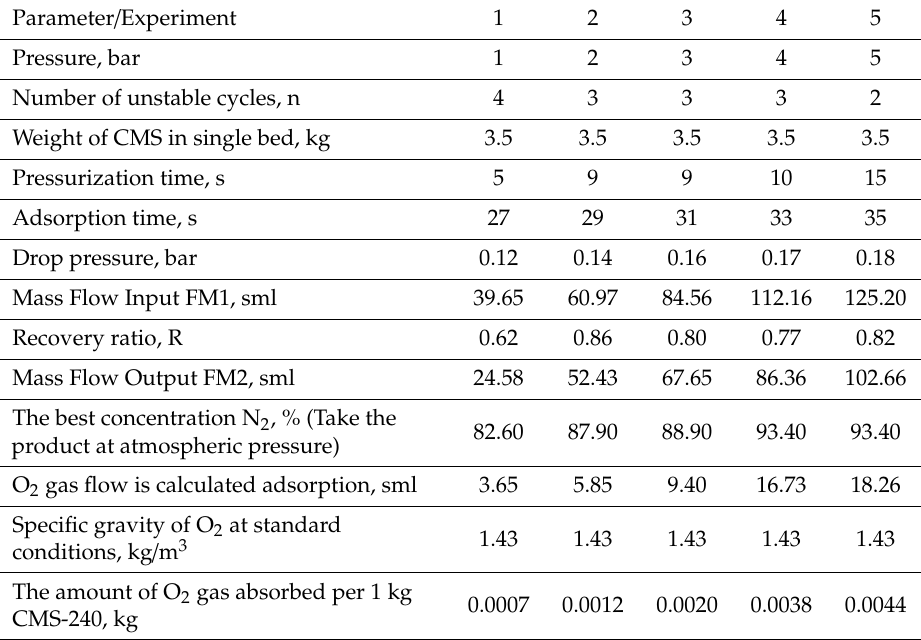
Table 4. Experimental results from 1 to 5